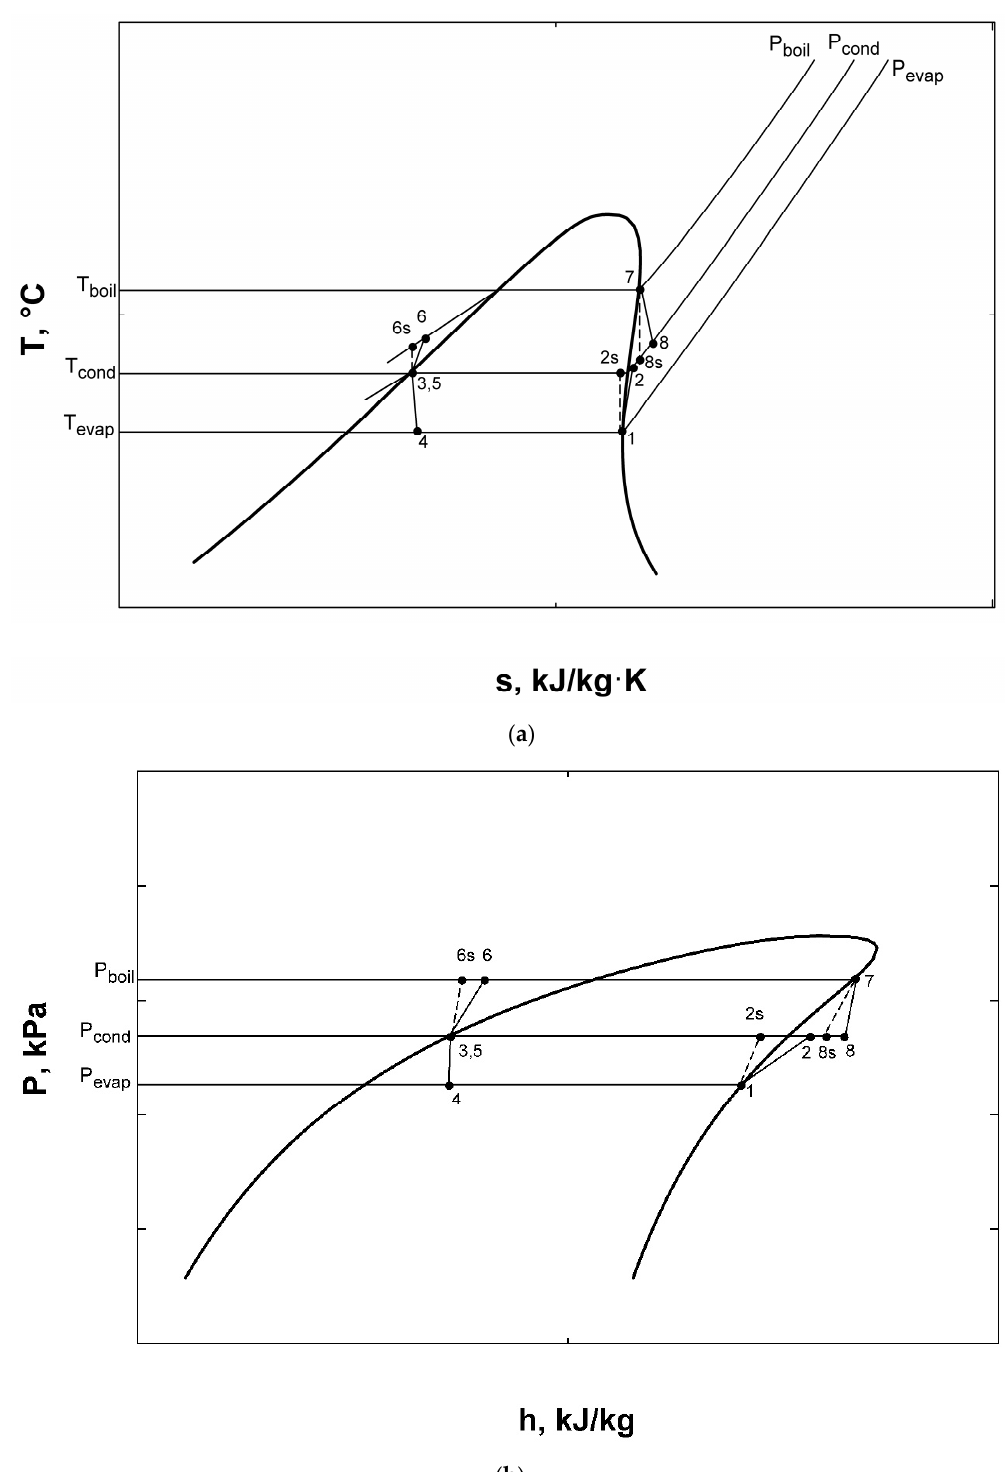
Figure 10. T-s ( a ) and P-h ( b ) diagrams for combined ORC-single evaporator VCR cycle.